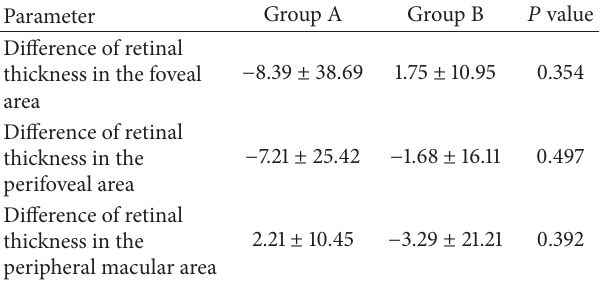
Table 4: Difference between retinal thicknesses in different parts of theeyebeforeandafterhemodialysisindiabeticretinopathypatients with (Group A) and without (Group B) macular